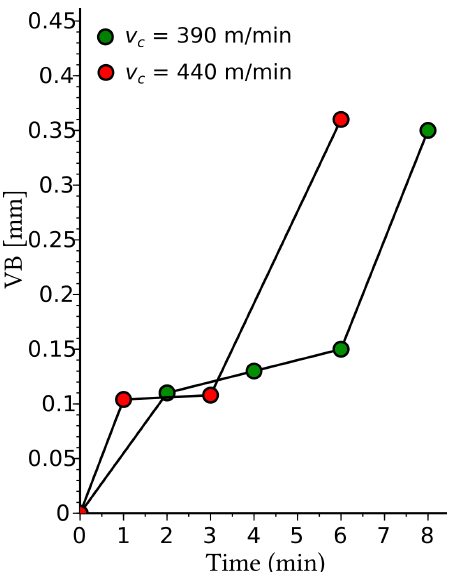
Figure 2. Experimental wear evolution measured at cutting speeds different from 340